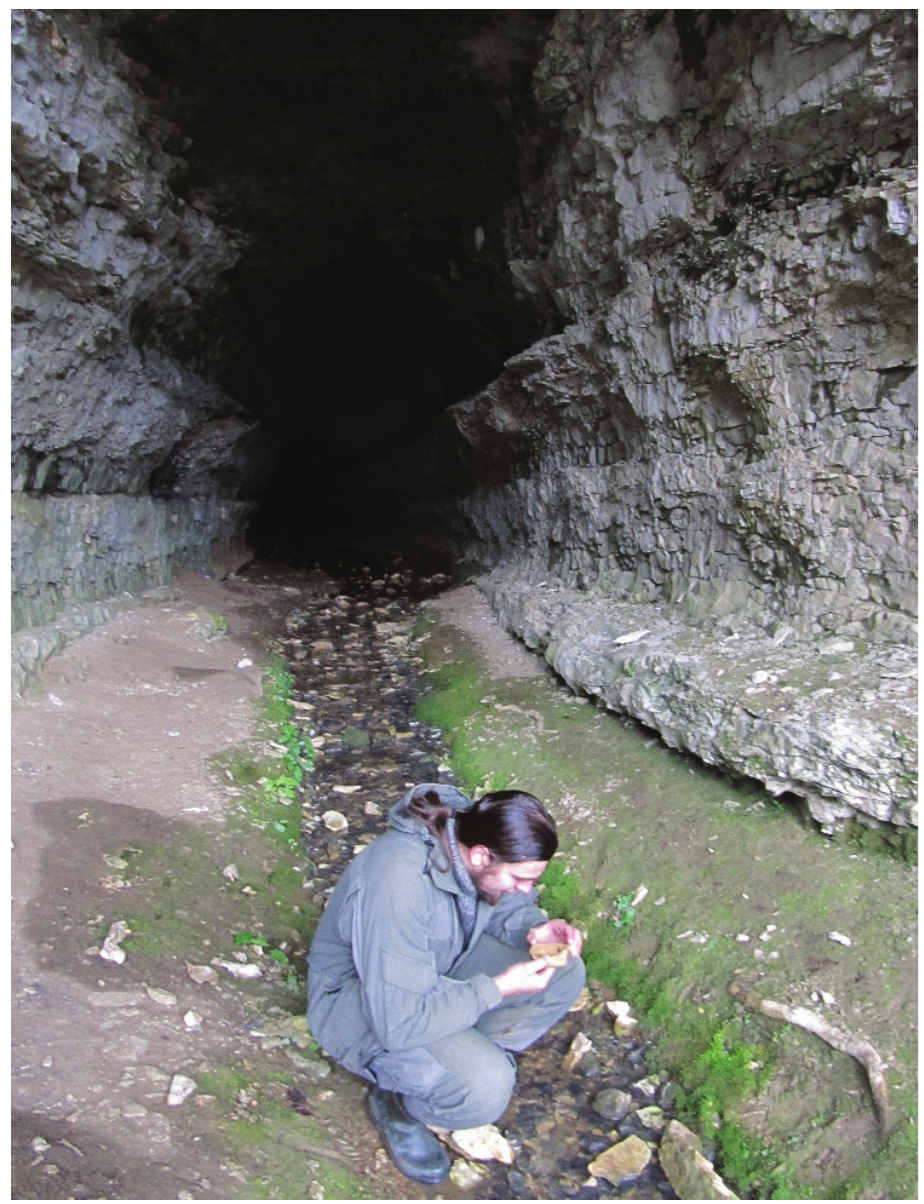
Figure 8. Habitat of Zenkevitchia yakovi sp. n. in the Sredne-Shakuranskaya cave, South Caucasus. One of the authors (DMP) sampling amphipods in the cave